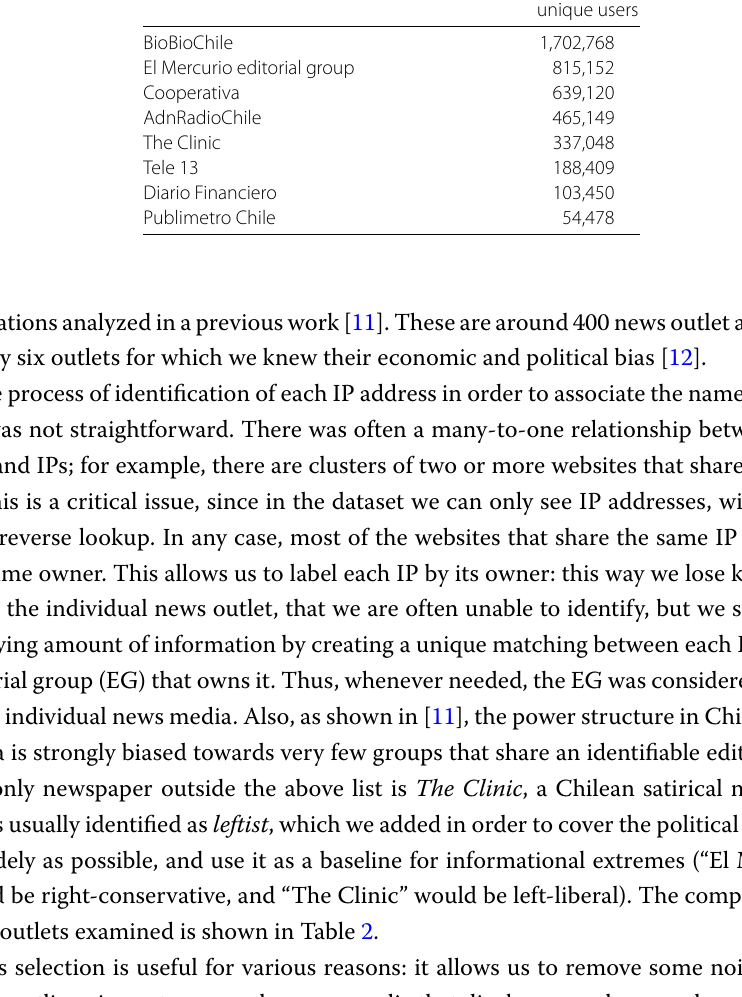
Table 2 List of news outlets (or editorial groups) examined in the DPI data set List of the news outlets